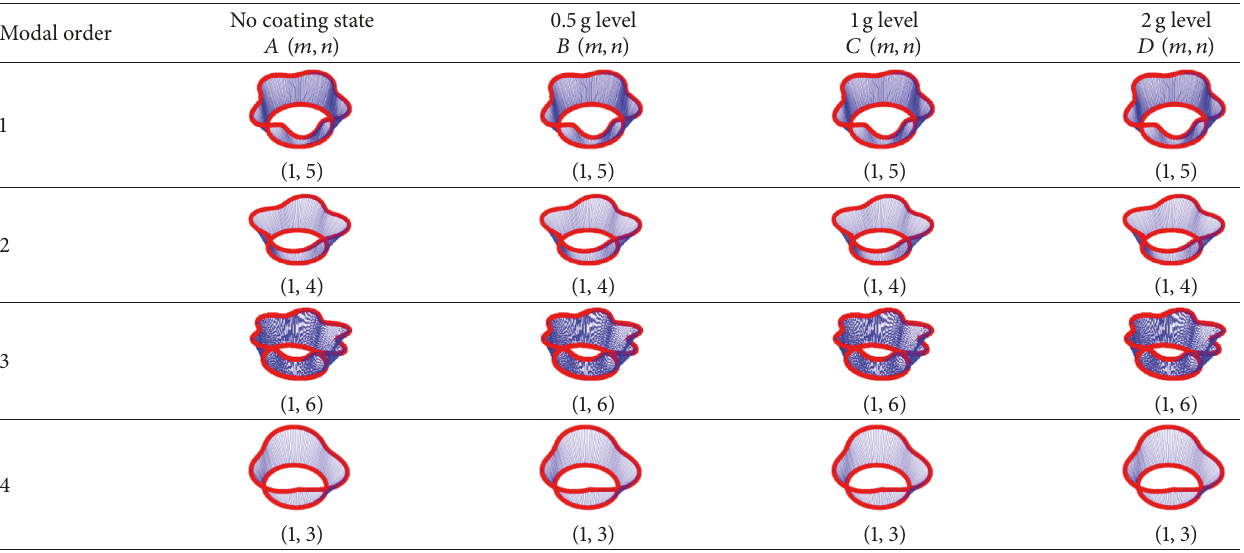
Table 11: The 5th to 8th mode shapes of cantilever cylindrical shell coated with and without hard coating under different excitation levels. Modal order